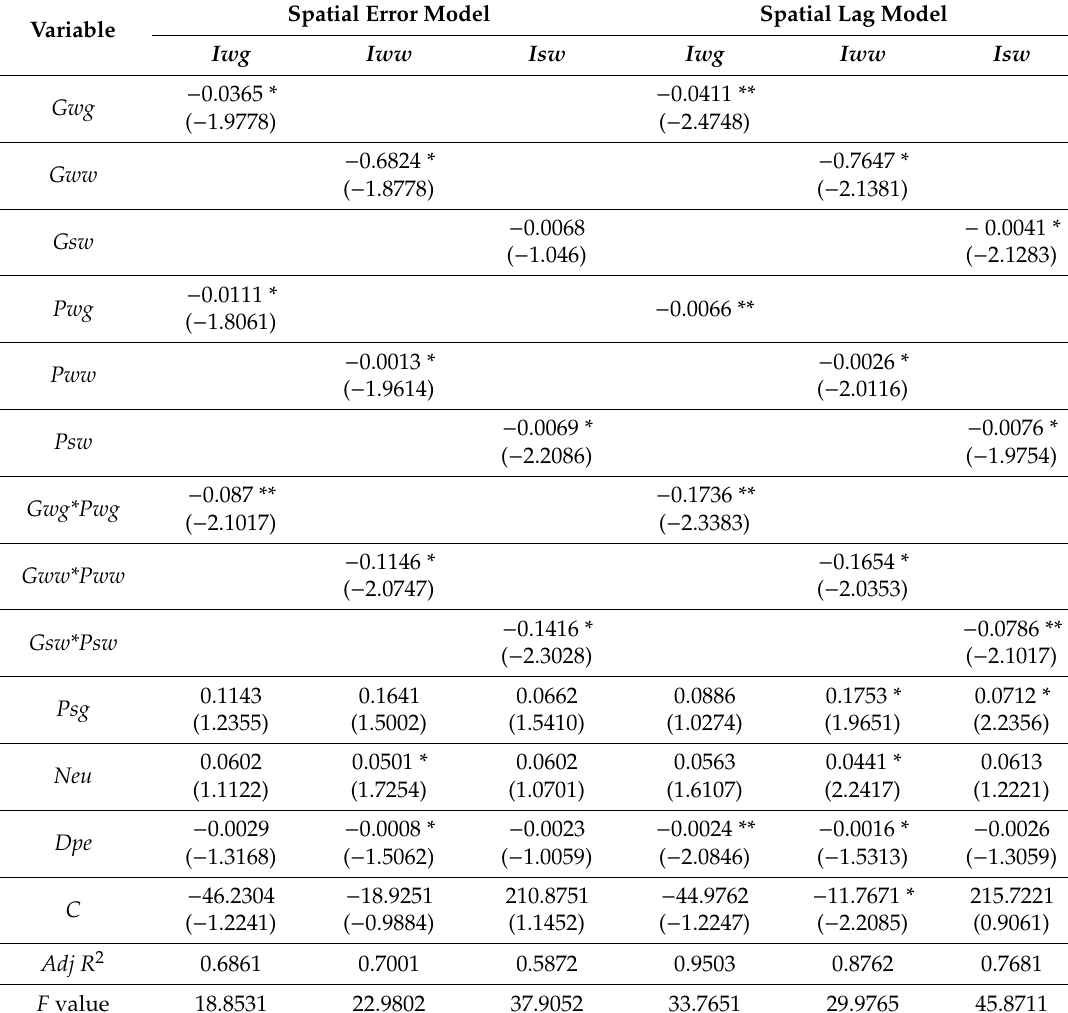
Table 5. The results of spatial error model and spatial lag